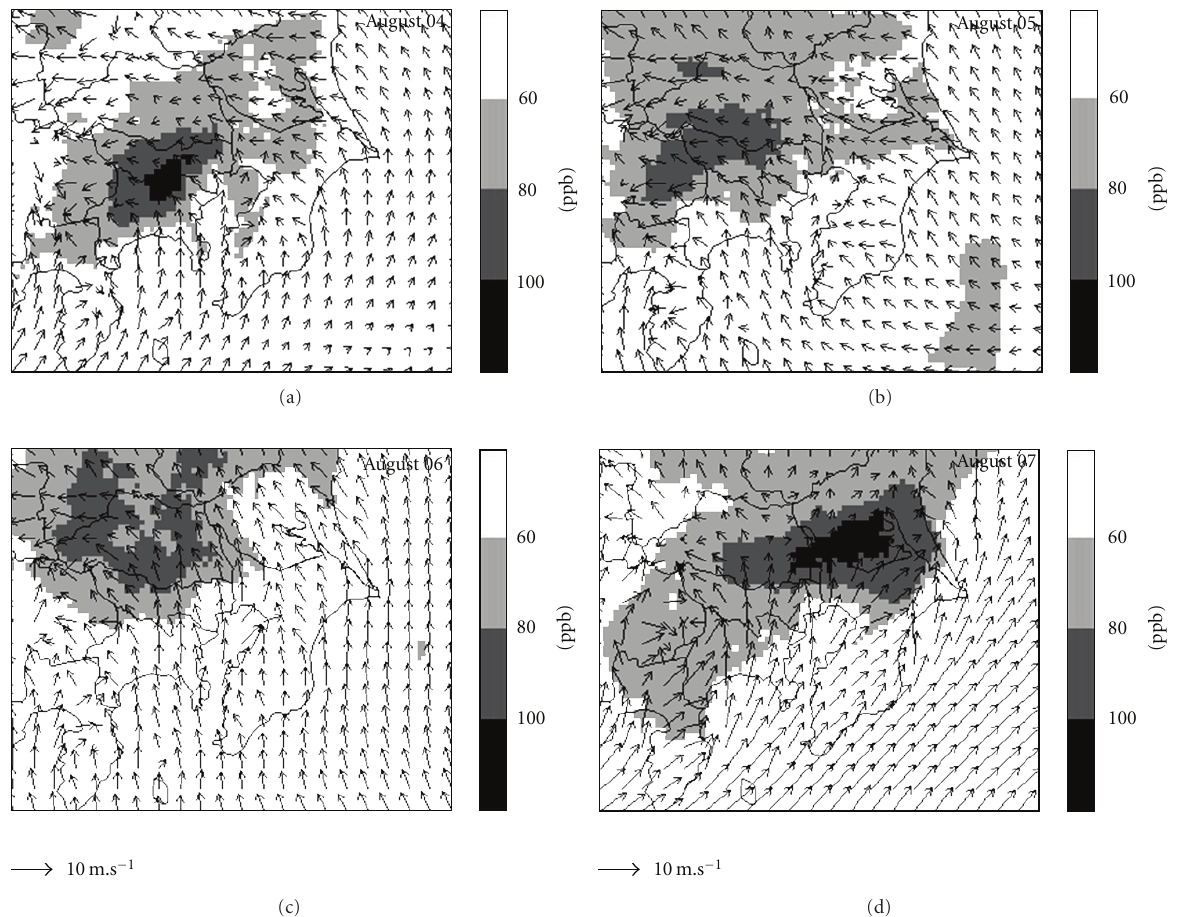
Figure 16: The spatial distribution of ozone under various conditions of local circulation at 14:00 JST during August 4–7, 2005 over the Kanto